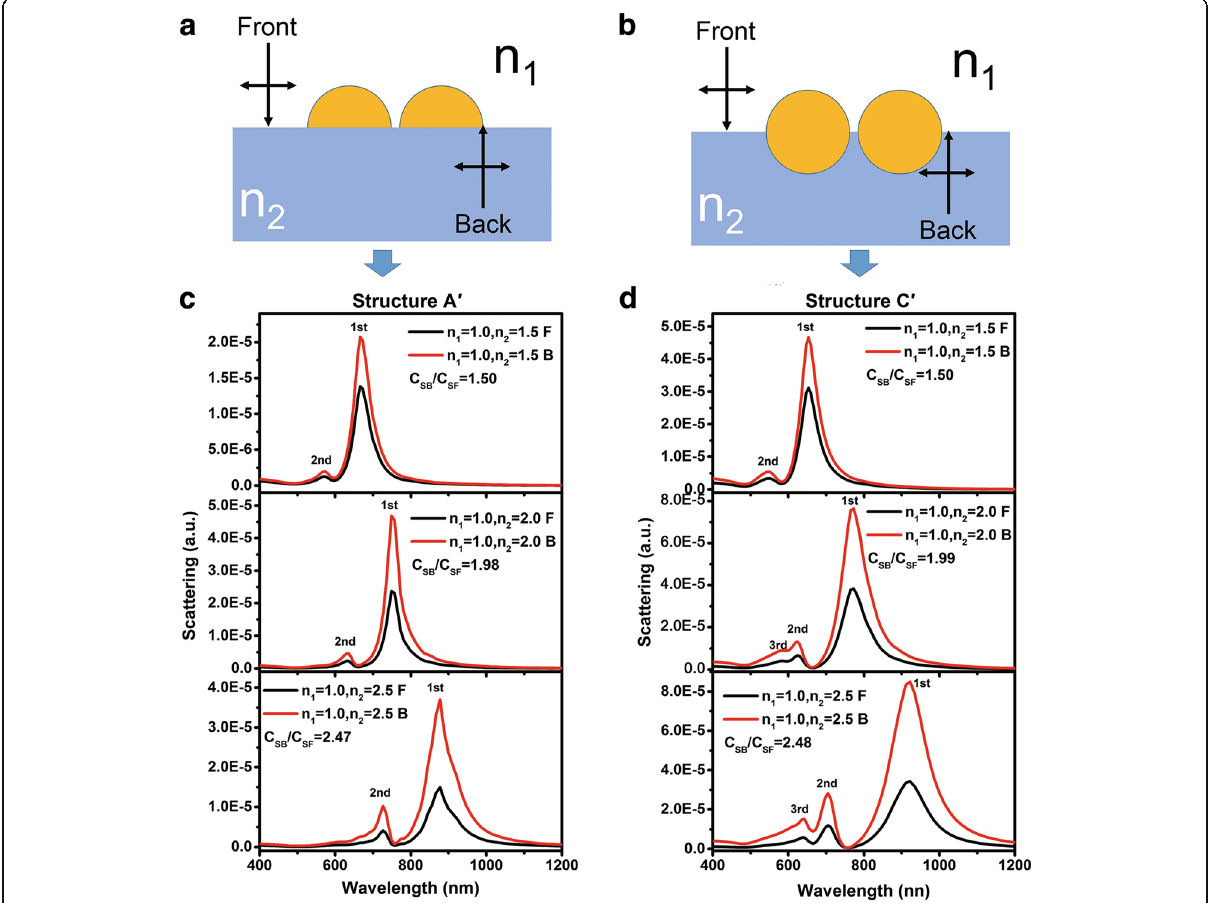
Fig. 7 a , b Schematic diagrams of structure A ′ and C ′ used for FDTD simulations respectively. c , d Scattering spectra for varying n 2 = 1.5, 2.0, and 2.5 of structure A ′ and structure C ′ respectively. Light is incident normally from air (denoted as black lines) and substrates (denoted as red